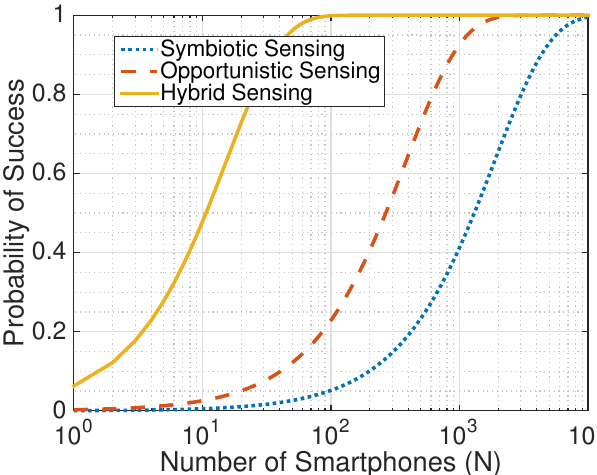
Figure 5. Evaluation of the NeriCell [13] honk detection application in terms of the success probability when applying opportunistic sensing (original work), symbiotic sensing, and hybrid